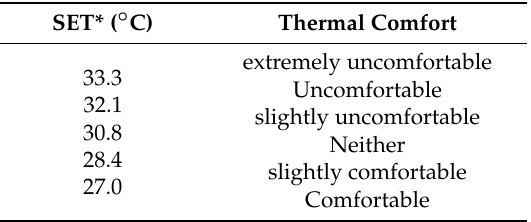
Table 2. Relationship between Standard Effective Temperature (SET*) and thermal